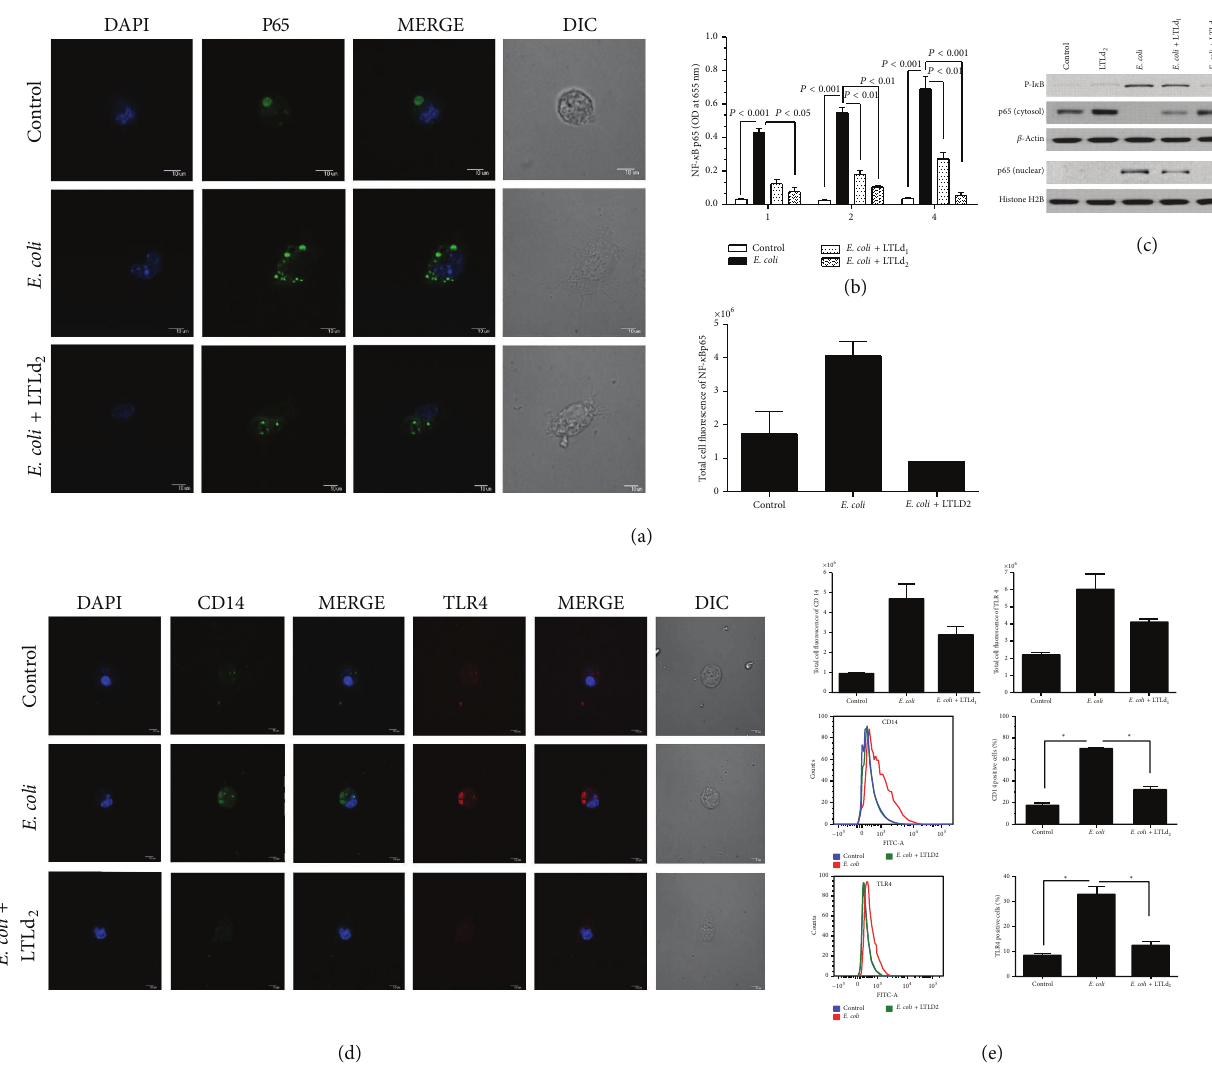
Figure 3: Effect of LTL on expression levels of (a) NF- 𝜅 B p65 in peritoneal macrophage cells after 4h incubation at concentration LTLd 2 (100 𝜇 g/mL) in the presence and absence of heat-killed E. coli (O18:K1; 1 × 10 8 CFU/mL), from immunofluorescence level measured by confocal laser scanning microscopy. (b) ELISA results showed the nuclear extract of NF- 𝜅 B p65 in peritoneal macrophage cells after 1, 2, and 4h incubation with LTLd 1 and LTLd 2 . (c) Western blot analysis revealed nuclear and cytosolic NF- 𝜅 B p65 levels and p-I 𝜅 B protein expression level after treatment with LTLd 1 and LTLd 2 following 12h incubation. (d) Immunofluorescence expression measured by confocal laser scanning microscopy (magnification 600x) and (e) by flow cytometry showing levels of CD14 and TLR4 in peritoneal macrophage cells after 4 h incubation at concentration LTLd 2 in the presence and absence of heat-killed E. coli (O18:K1; 1×10 8 CFU/mL). The data are reported as the mean ± SEM of triplicate experiments ( ∗ 𝑃 < 0.05 , ∗∗ 𝑃 < 0.01